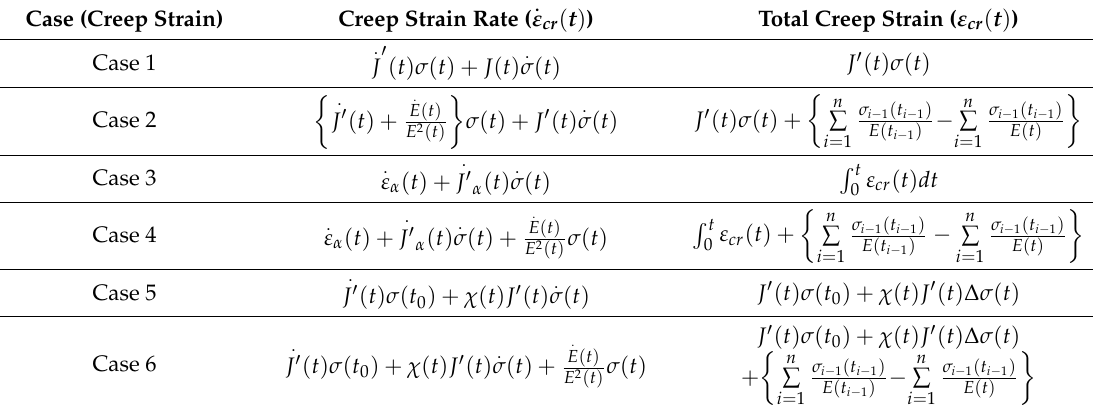
Table 2. Creep model equations corresponding to the creep